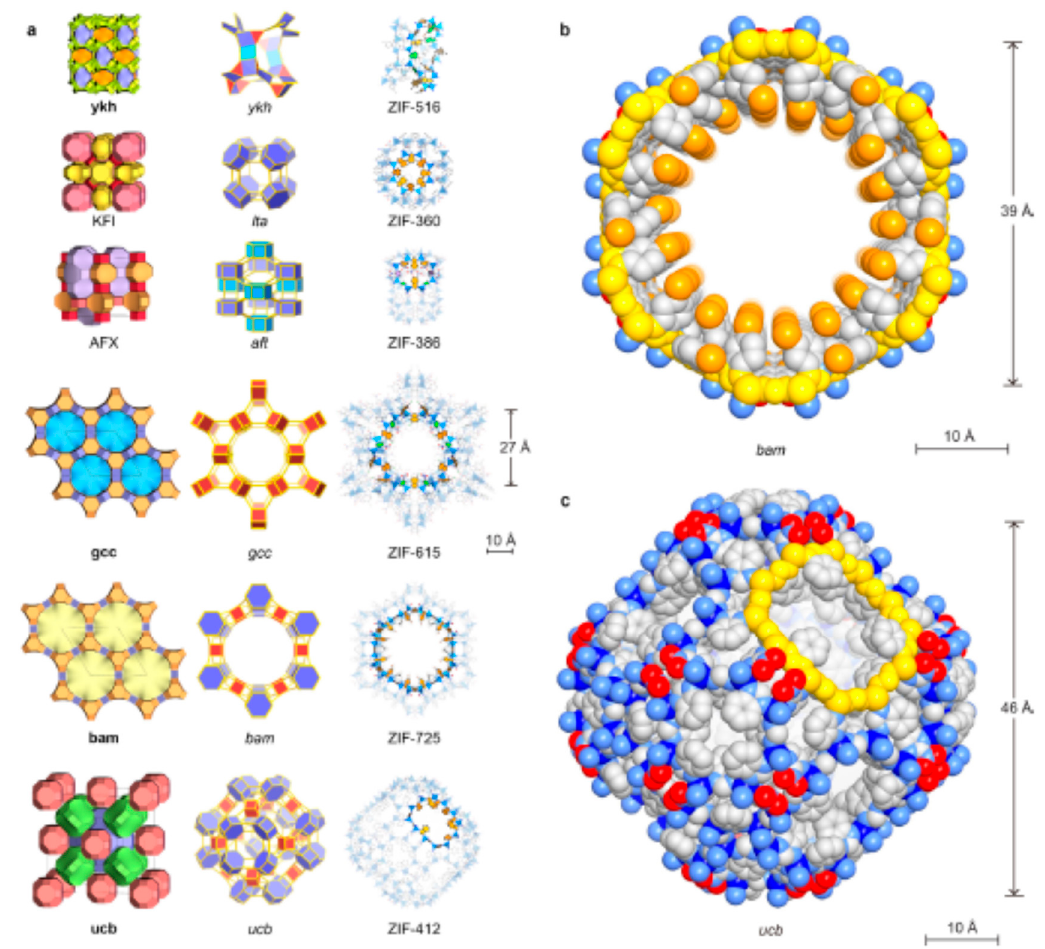
Figure 7. Crystal structures of the new ZIFs. Topologies are shown in natural tilings. The largest cages are presented with adjacent small cages, and characteristic cages are shown with ball-and-stick structures for linkers (N, blue; C, dark; O, red; Cl, green; Br, orange, H, omitted for clarity) and blue tetrahedra for ZnN4 units. ( a ) KFI, ZIF-360; AFX, ZIF-386; ykh, ZIF-516; gcc, ZIF-615; bam, ZIF-725; ucb, ZIF-412. Largest openings for each cage are highlighted. ( b ) Space-filling views for the channel in bam ZIF (ZIF-725) are shown (zinc, blue; N, light blue; C, gray; O, red; Br, orange). The 24-MR aperture (bam ZIF-725, 96 atoms) is highlighted in yellow. ( c ) Space-filling view for the largest cage in ucb ZIFs (illustrated by ZIF-412) is shown: zinc, blue; N, light blue; C, gray; O, red. The 12 MR opening (ucb ZIF-412, 48 atoms) is highlighted in yellow. Reproduced with permission from [7].